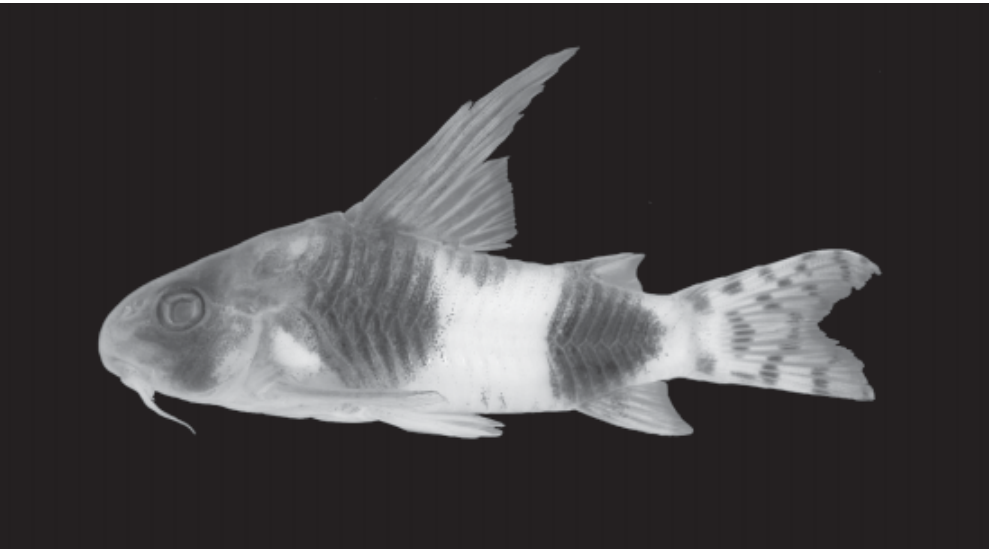
Fig. 3. Corydoras tukano , paratype, MZUSP 81179, presumably a mature male, 36.1 mm SL; Brazil, estado do Amazonas, rio Tiquié, comunidade de Boca do